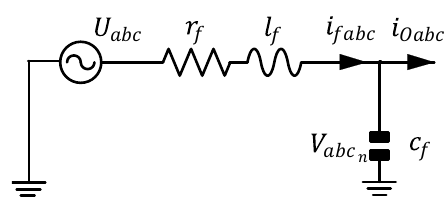
Figure 3. Single phase diagram of an